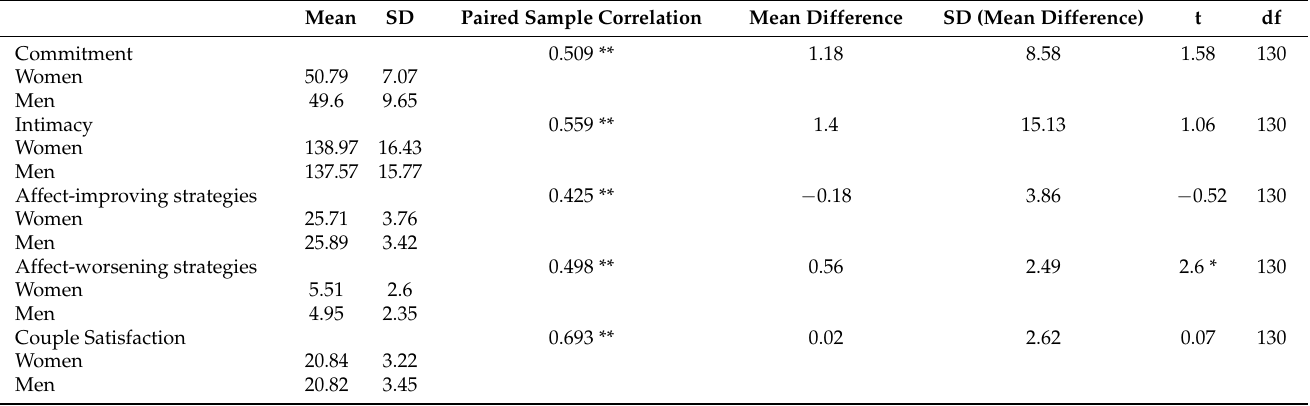
Table 1. Descriptive statistics and paired-sample t -tests for this study’s variables.